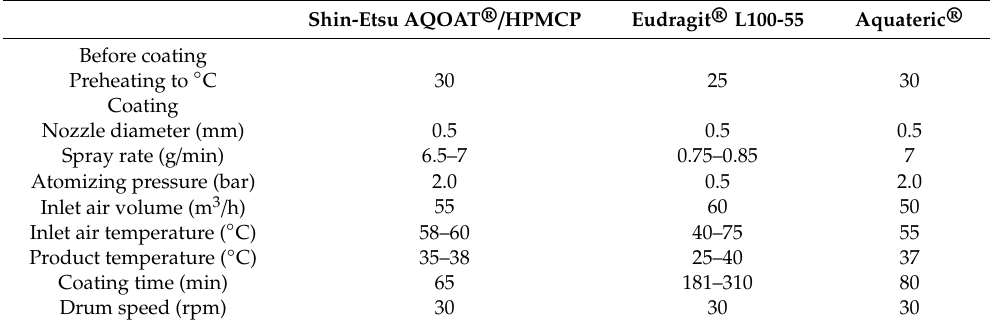
Table 6. Operating parameters for coating of HPMC capsules with enteric polymers on the drum coater.